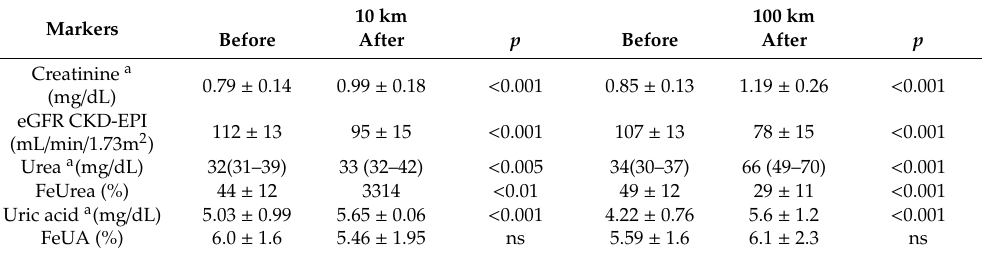
Table 5. Change in basic uremic toxins after both races.